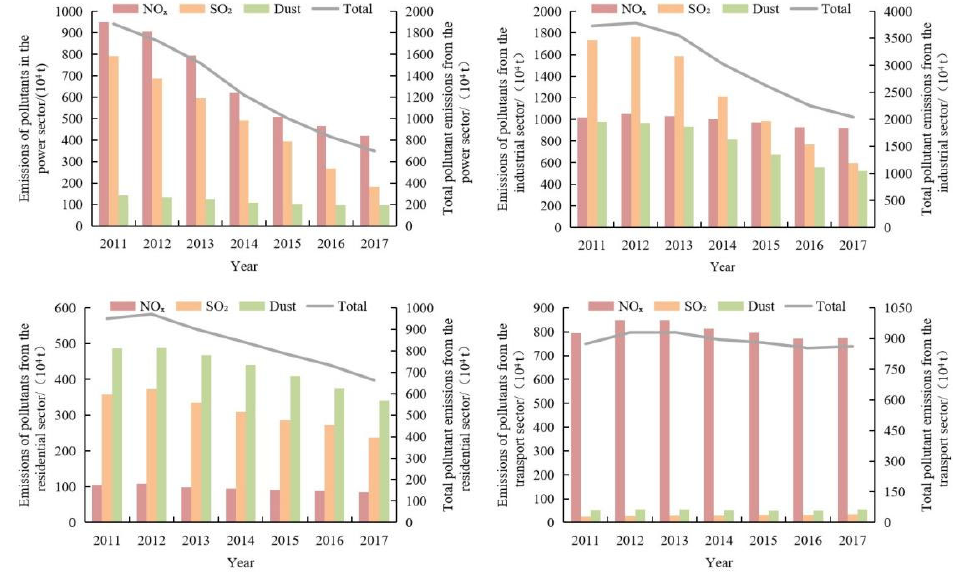
Figure 4. Emissions of NO x , SO 2 , and dust in China (2011 – 2017) from various economic sectors. Table 1. Proportional emissions reductions in different economic sectors in China (2011 – 2017).